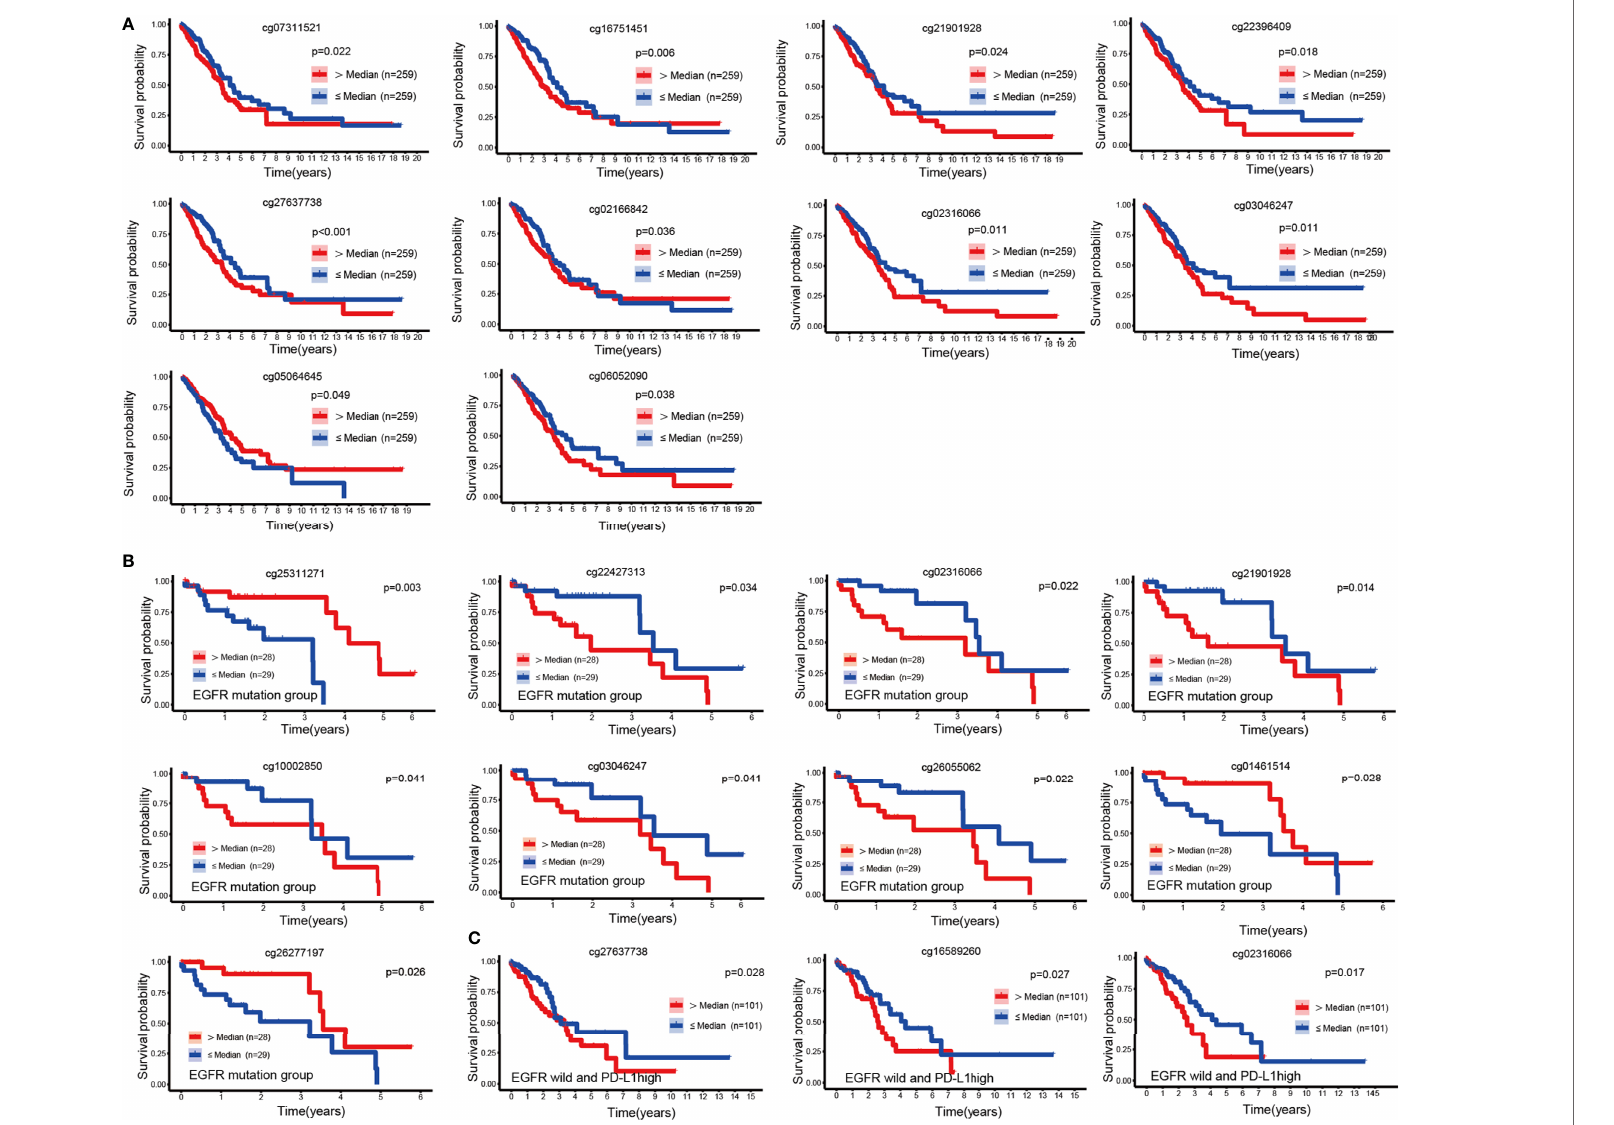
FIGURE 2 | KM curves of EGFR CpG sites. (A) Kaplan-Meier analysis regarding overall survival in patients with LUAD strati fi ed according to EGFR methylation CpG sites. (B , C) Kaplan-Meier analysis of the overall survival rate of LUAD patients based on the EGFR mutation group and the EGFR wild-type PDL1 high expression